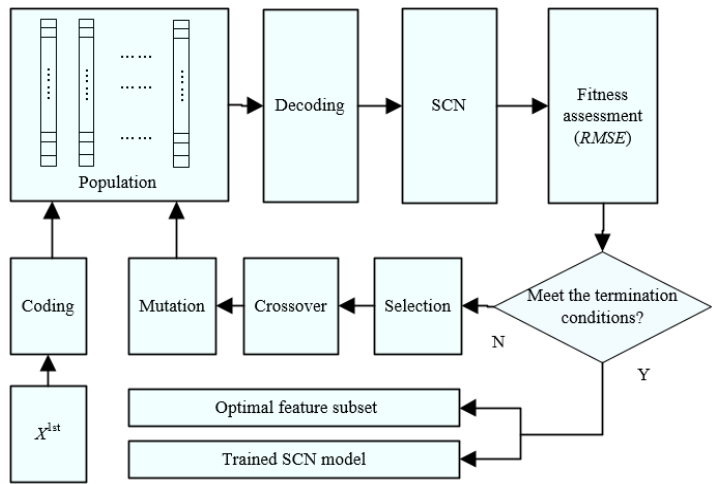
Figure 2. Secondary feature selection procedure based on GA-SCN.